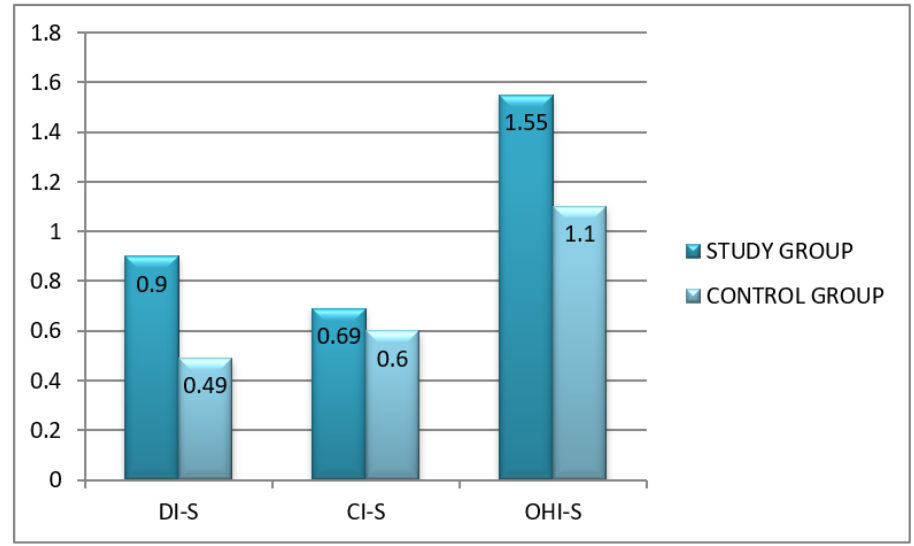
Figure 3. A detailed analysis of oral hygiene using OHI-S index: DI-S—debris; CI-S—calculus; in the study group vs. control group.